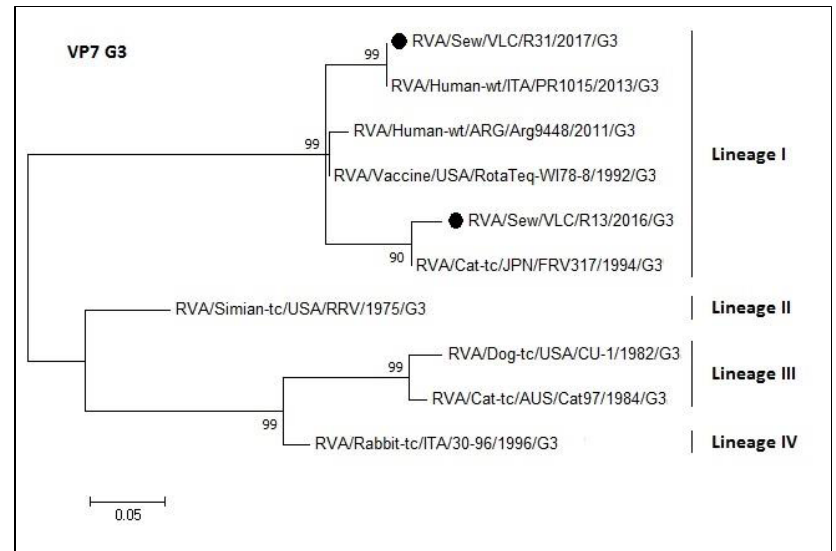
Figure 7. Molecular phylogenetic analysis of G3 rotavirus (VP7 gene). The evolutionary history was inferred by using the Maximum Likelihood method based on the Tamura 3-parameter model [43] with a bootstrap of 1000 replicates. The tree is drawn to scale, the branch lengths measure the number of substitutions per site. The analysis included 10 nucleotide sequences. There was a total of 159 positions in the final dataset including nucleotides from 774 to 933.